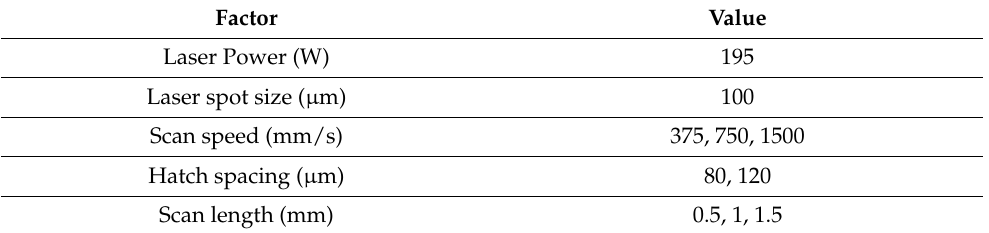
Table 1. Experimental design used to fabricate multi-track samples.